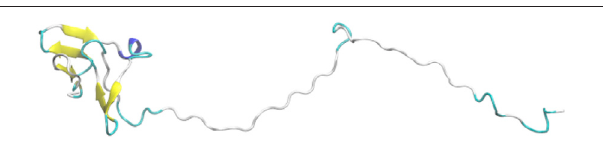
FIGURE 1 | An atomic model of UL11 predicted by